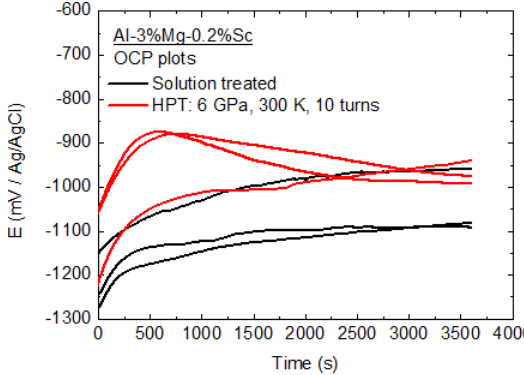
Figure 2. Open circuit potential variation with time for solution treated and HPT-processed alloy in 3.5 wt./v.% NaCl solution